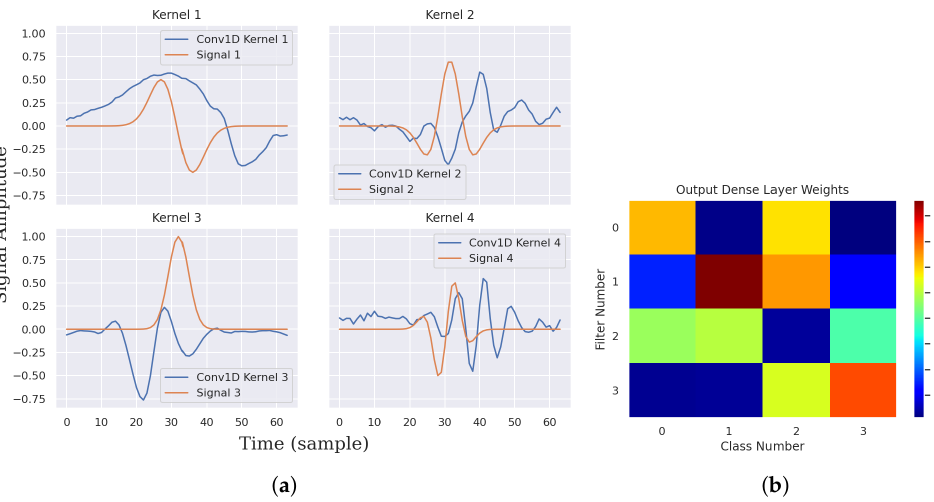
Figure 4. Learned Conv1D and FC output layer kernel weights for the synthetic dataset with N = 4, N T [ i ] = 10000 for i ∈ { 0,1,2,3 } , P = 50%, N c = 4, N DS = 40,000, balanced dataset, and the third model variant with N F = N c = N = 4, N k = 64 , N S = 128. ( a ) Learned Conv1D filters versus template signals. ( b ) Learned kernel weights of the FC output